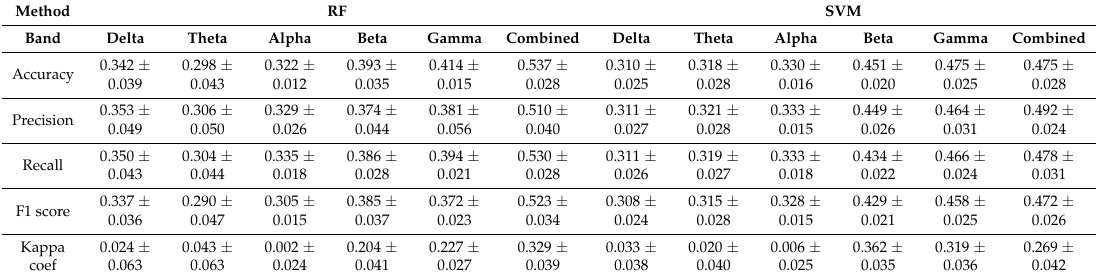
Table 2. Predictive performance with five methods using the original dataset and Linear Discriminant Analysis (LDA).